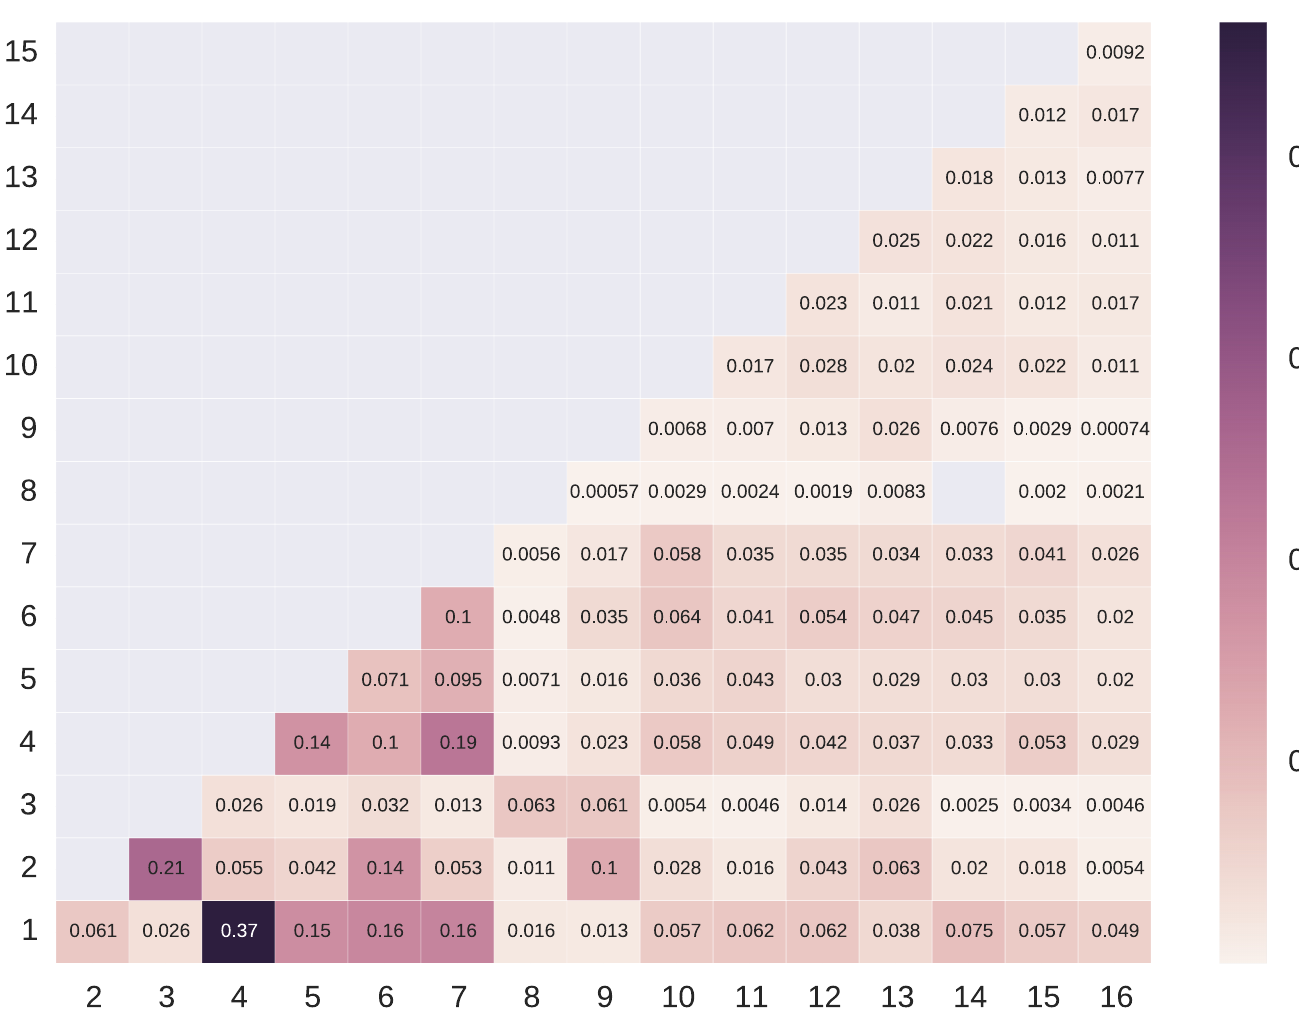
Fig 2. Levels of interaction between clusters in Copenhagen. Cells show the average number of mutual ties per user between members of two clusters. Darker shaded cells indicate a greater number of mutual ties. Blank cells indicate an absence of